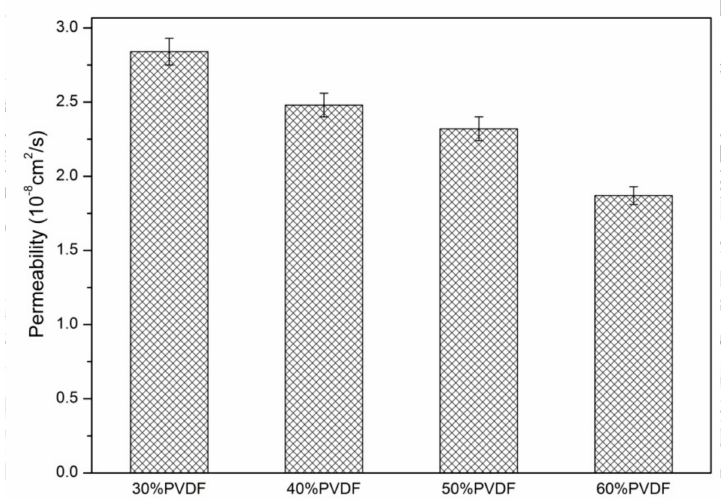
Figure 3. Methanol permeability through the s -PI-polyvinylidene fluoride (PVDF) composite